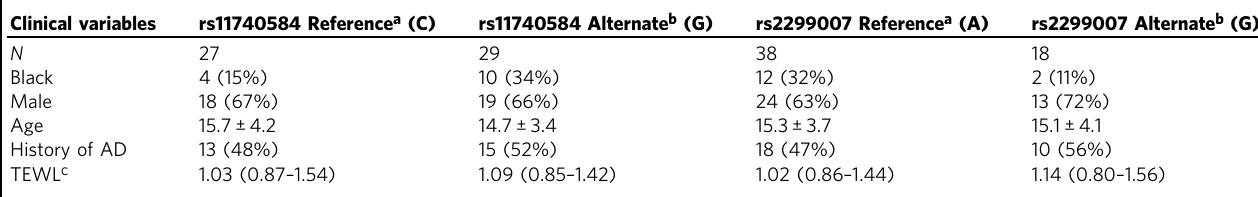
Table 1 Clinical and demographic characteristics of individuals carrying the reference vs. alternate alleles of KIF3A SNPs rs11740584 and rs2299007.